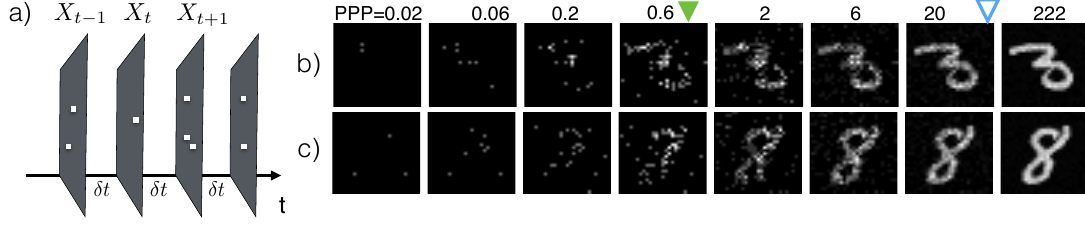
Figure 1. Synthetic low-light images. ( a ) A photon-counting sensor outputs a matrix of photon counts X t with a period of δ t . ( b,c ) Sample synthetic low-light images from the Mixed National Institute of Standards and Technology (MNIST) dataset [11] used in the classification experiments (Section 2.2.2) with increasing average photons per pixel (PPP). PPP is proportional to the exposure time t . Blue hollow arrows indicate the median PPP required for the proposed algorithm (Section 2.2.1) to achieve the same error rate (0.7%) as a model trained and tested using images under normal lighting conditions with about 2 7 10 4 PPP. Green solid arrows indicate the median PPP required to to maintain error ≈ rates below